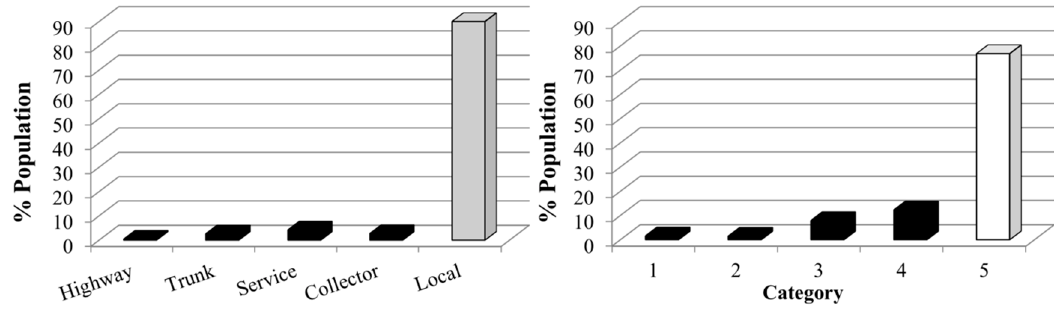
Figure 7. Population exposed to noise in different road categories and road types.